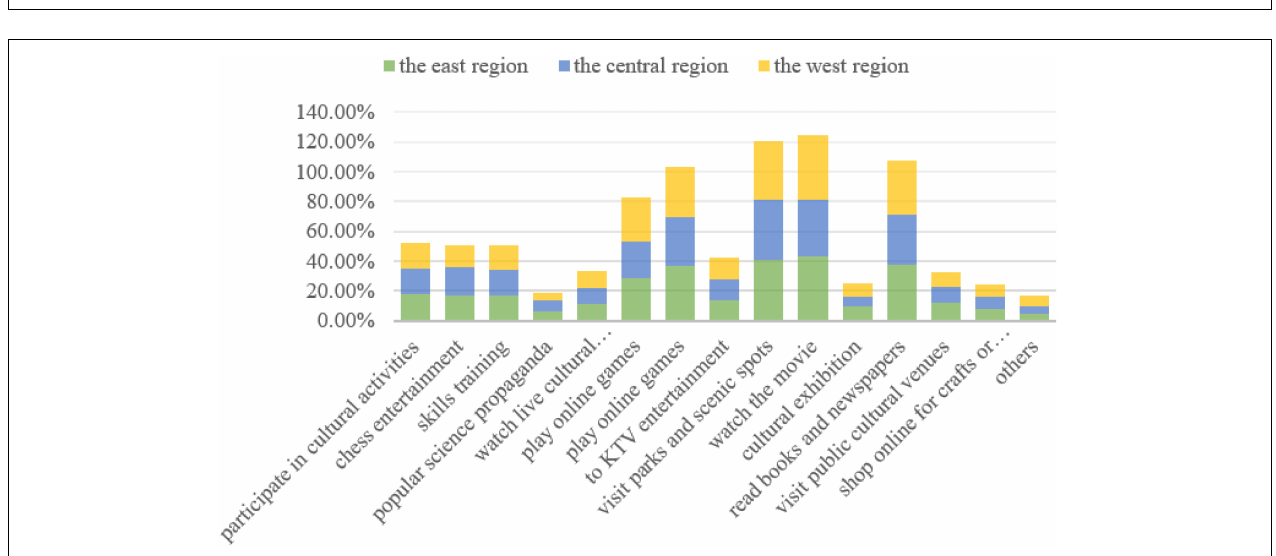
FIGURE 1 | The main content of respondents participating in public cultural activities in China.